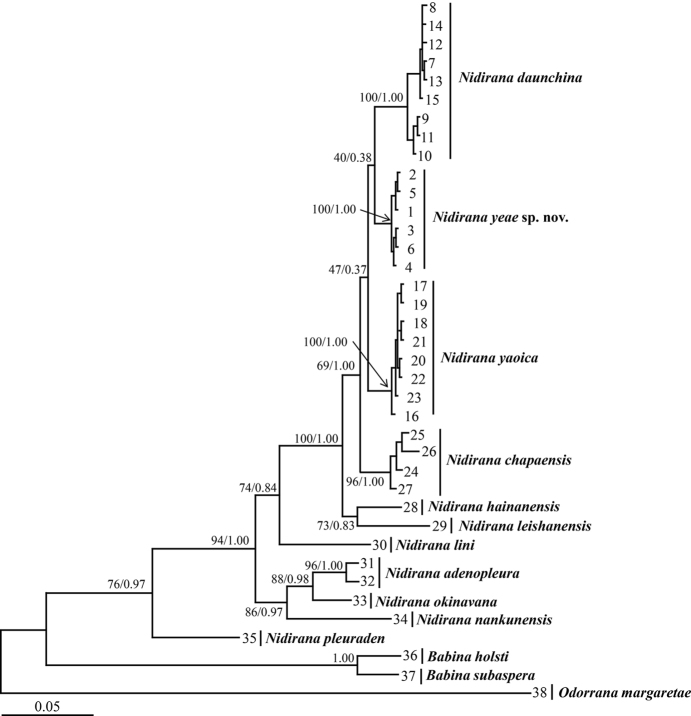
Maximum Likelihood (ML) tree based on the mitochondrial 16S and COI gene sequences. Bootstrap supports from ML analyses/Bayesian posterior probabilities from Bayesian Inference (BI) analyses are labelled beside nodes. Information of samples 1–38 in Table 1.